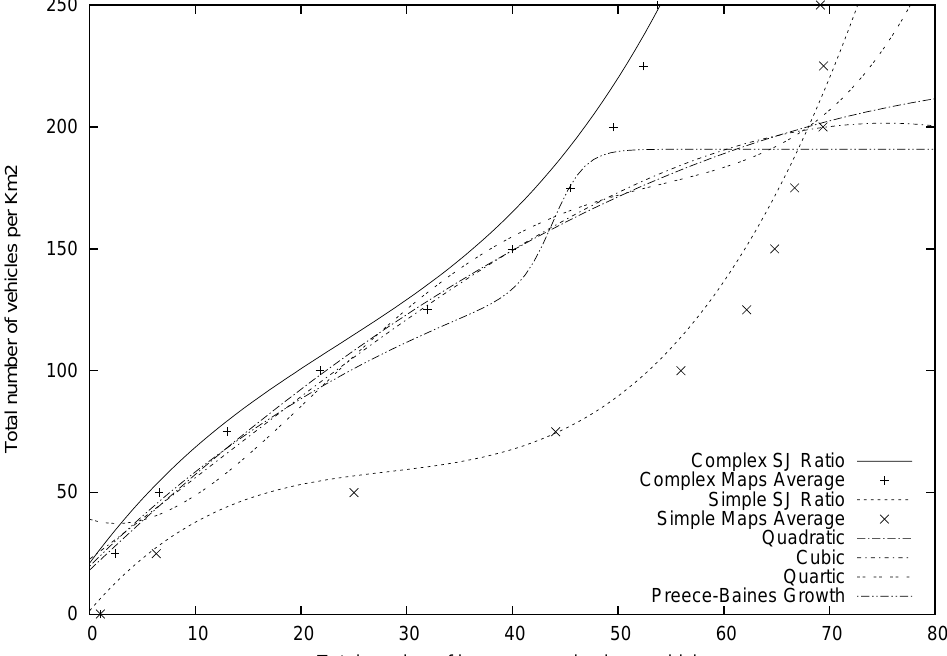
Figure 8. Graphical comparison between simulated and estimated results for each